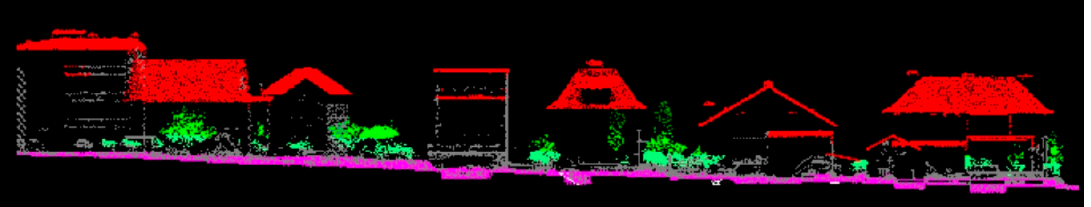
Figure 4. Classified ALS point cloud (2019); class (2) ground in pink color; class (6) buildings—in red; and vegetation—in green color.